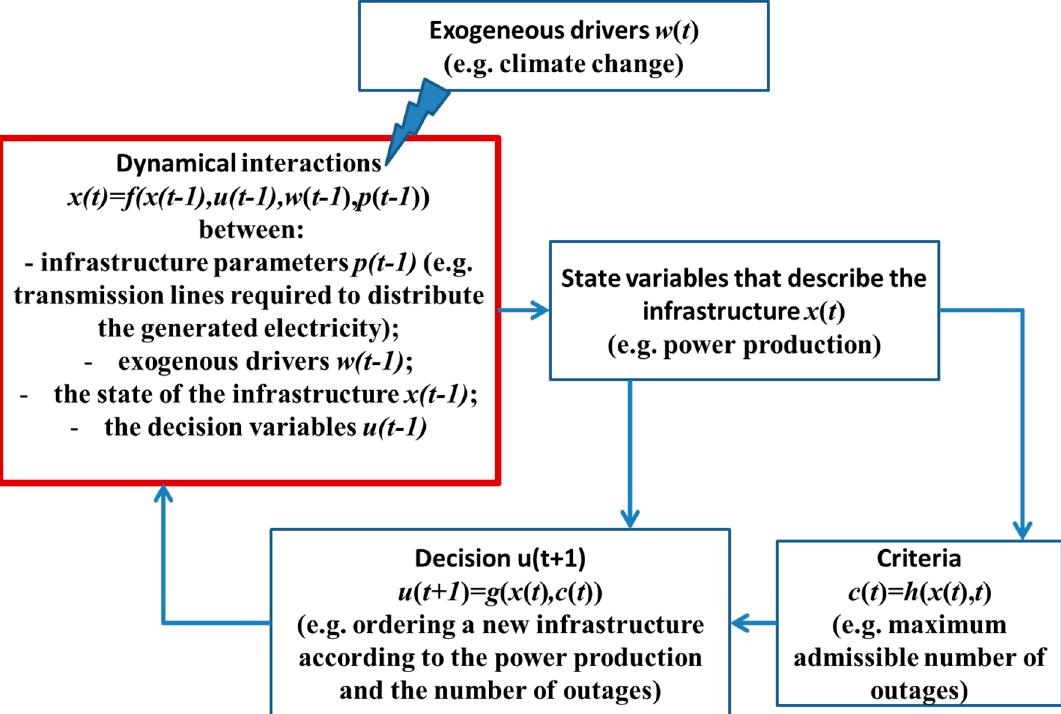
Figure 2. Outcome-based approach. This approach is based on a dynamical controlled system framework. According to the state of the system and management objectives, control u is decided. This framework enables managers to classify outcomes, including state variables, criteria, control, exogenous drivers, and dynamics of the system.